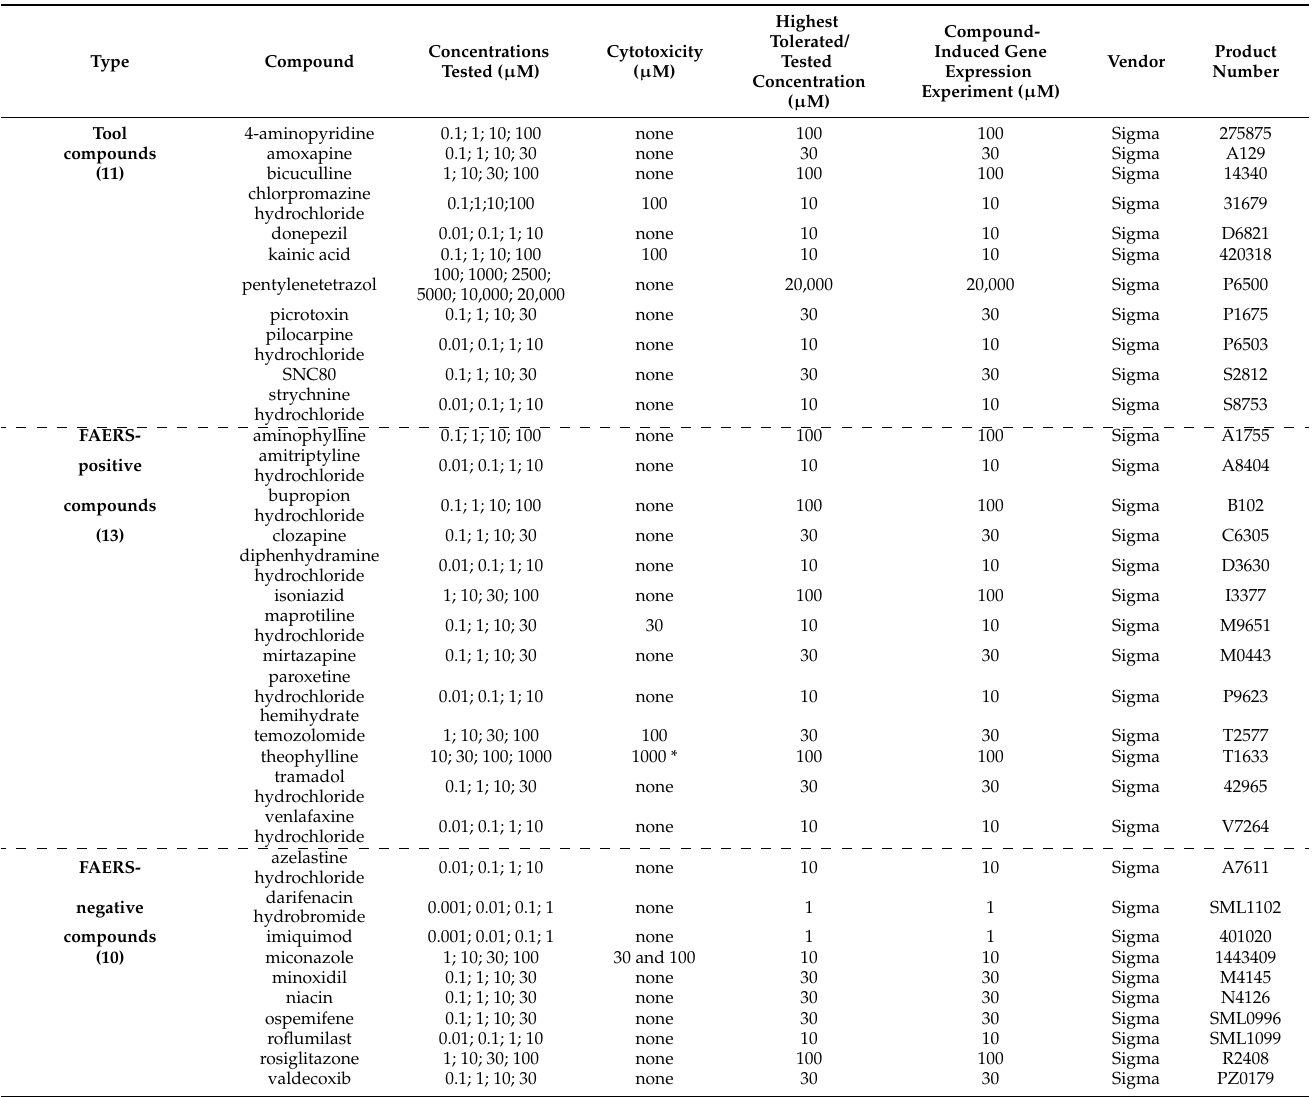
Table 8. Concentration range assessed ( µ M), compound-induced cytotoxicity in the rat cortical neuronal cultures, the highest tolerated or tested concentration, and the concentration selected for the compound-induced gene expression experiment of the 11 tool, 13 FAERS-positive, and 10 FAERS- negative compounds. The vendor and product number of the compounds purchased are shown in the right-hand columns. The concentrations for cytotoxicity testing were selected based on a literature review of known therapeutic plasma concentration in